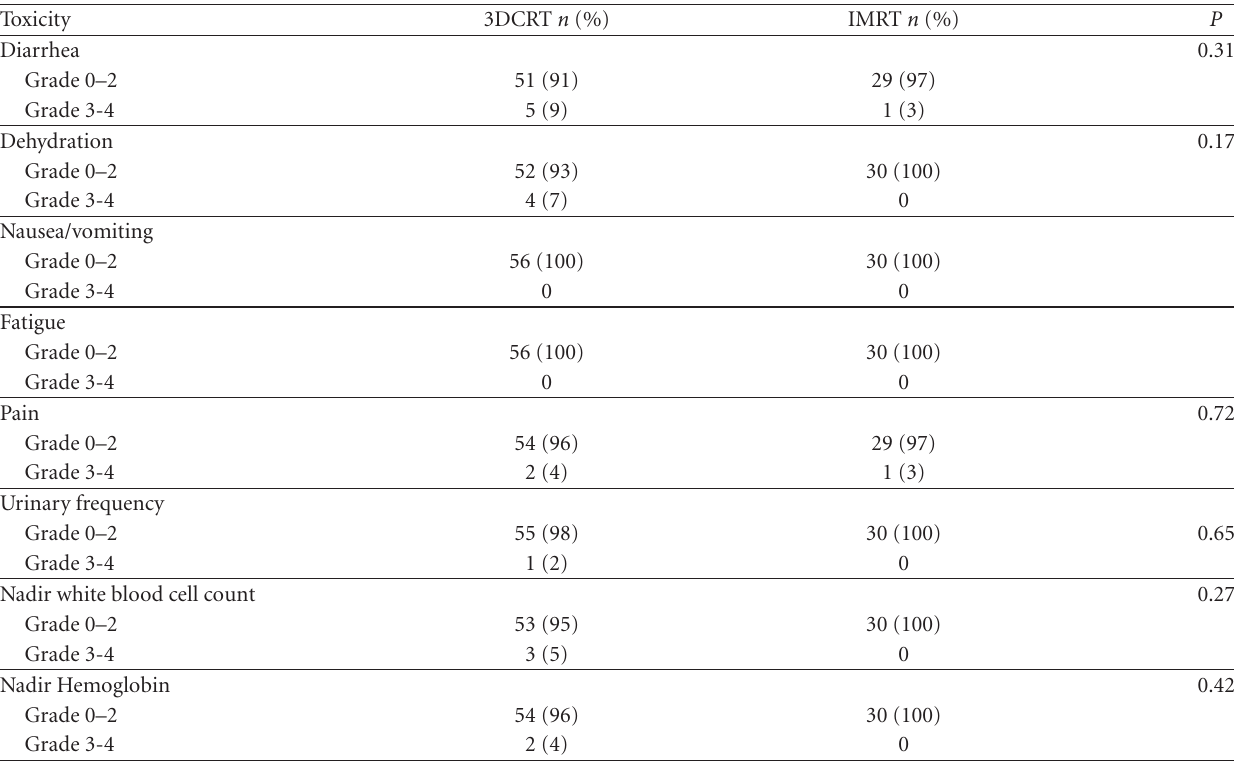
Table 2: Rates of toxicity by CTCAE